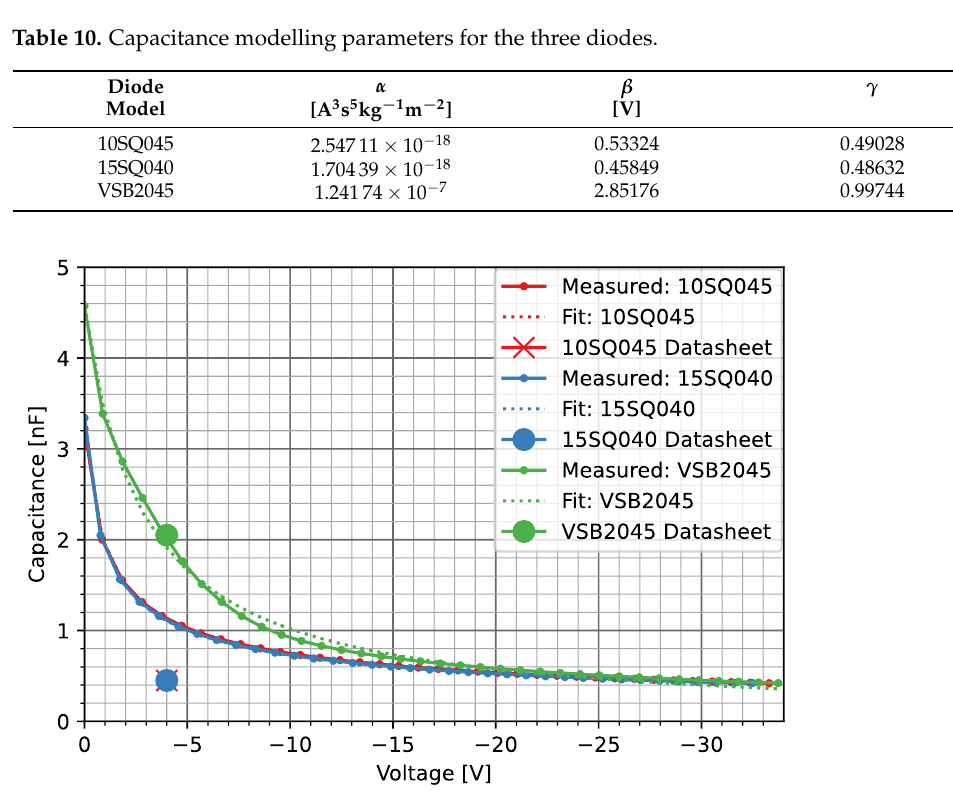
Figure 28. Measured, fit, and datasheet reverse bias capacitances for the three